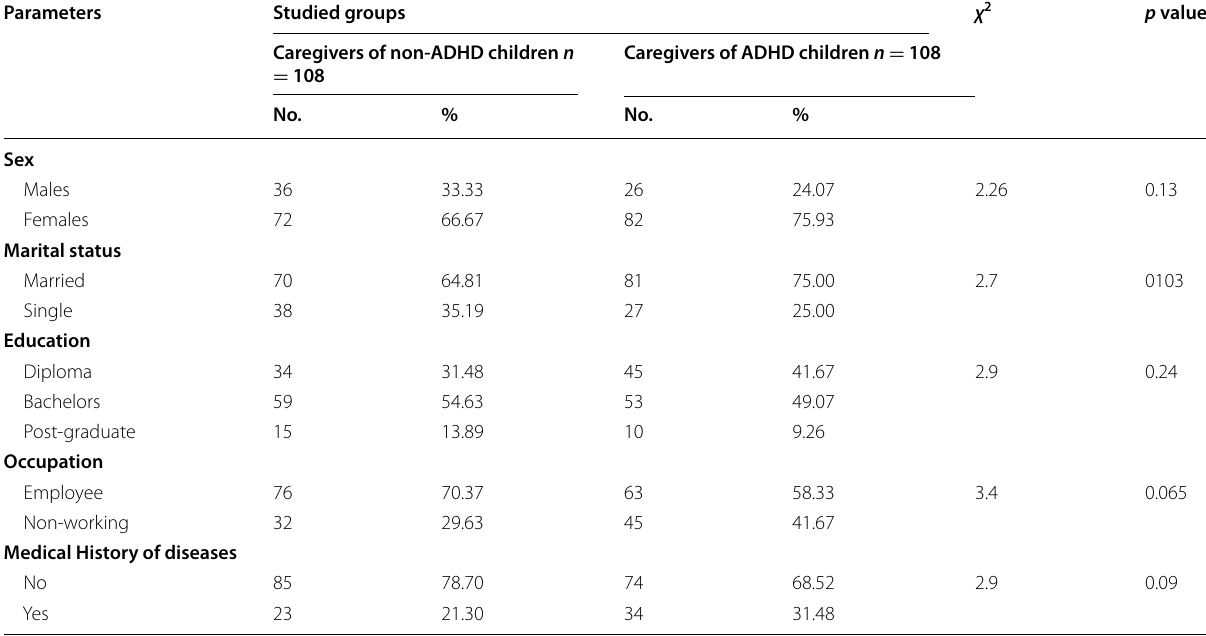
Table 1 Comparison between caregivers of non‑ADHD children and ADHD children regarding socio‑demographic characters (each group =